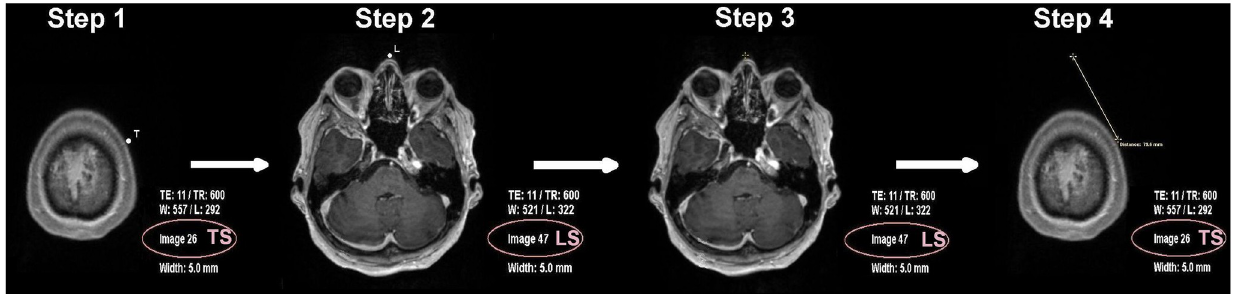
Fig 2. Calculating part. Assessment of the distance between the Landmark L and the target T , shown for nasion as landmark. For step-by-step explanations see paragraph Calculating part and the video guide . TS target slice, LS landmark slice.